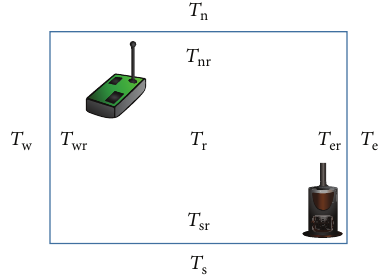
Figure 6: Single zone model consisting of a heat source and a wireless